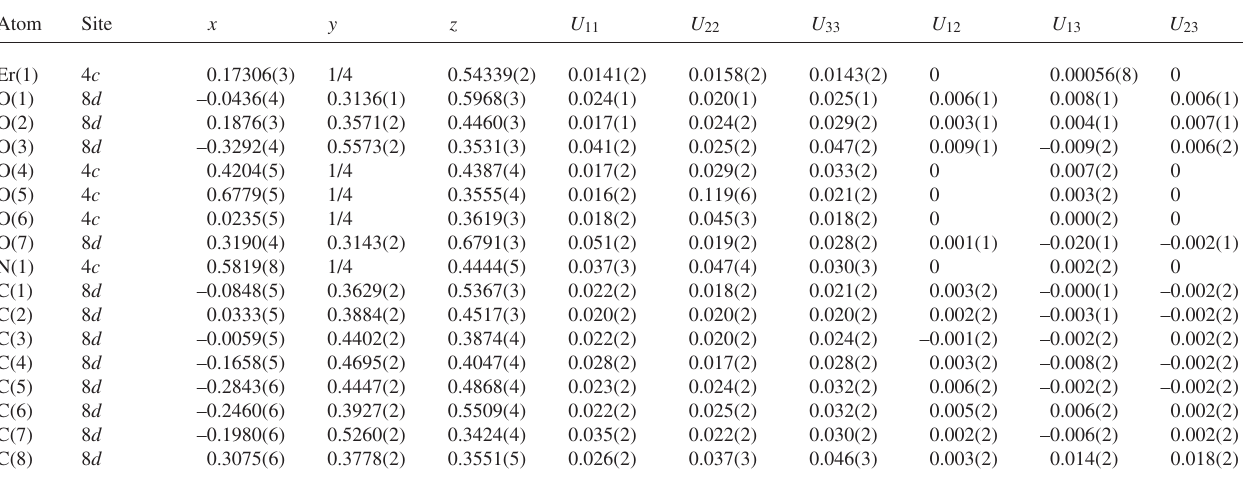
Table 3. Atomic coordinates and displacement parameters (in Å 2 )